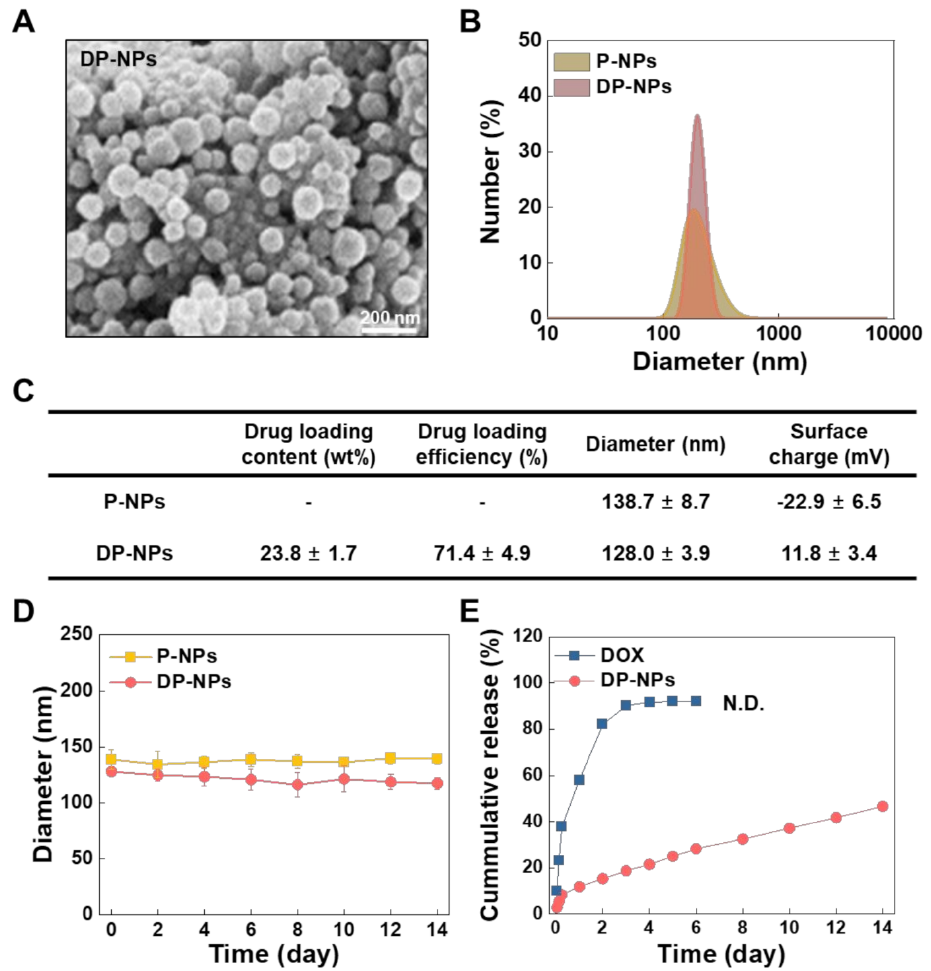
Figure 1. Physicochemical properties of the P-NPs and DP-NPs. ( A ) The morphology of the DP-NPs using FE-SEM. The scale bar indicates 200 nm. ( B ) The hydrodynamic size distribution of the P-NPs and DP-NPs using a zeta-sizer. ( C ) The DOX loading content and efficiency, particle size and surface charge of the P-NPs and DP-NPs using UV–vis spectroscopy and a zeta-sizer. ( D ) The size stability of the P-NPs and DP-NPs was monitored under 10% (v/v) FBS-containing PBS at 37 ◦ C for 2 weeks under 0.1% (v/v) tween 80-containing PBS at 37 ◦ C for 2 weeks. The released amount of DOX